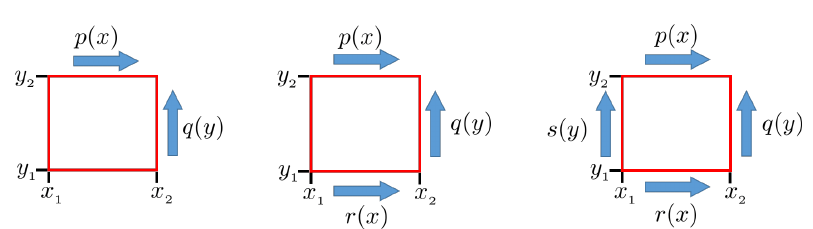
Figure 2. Examples of shear-type